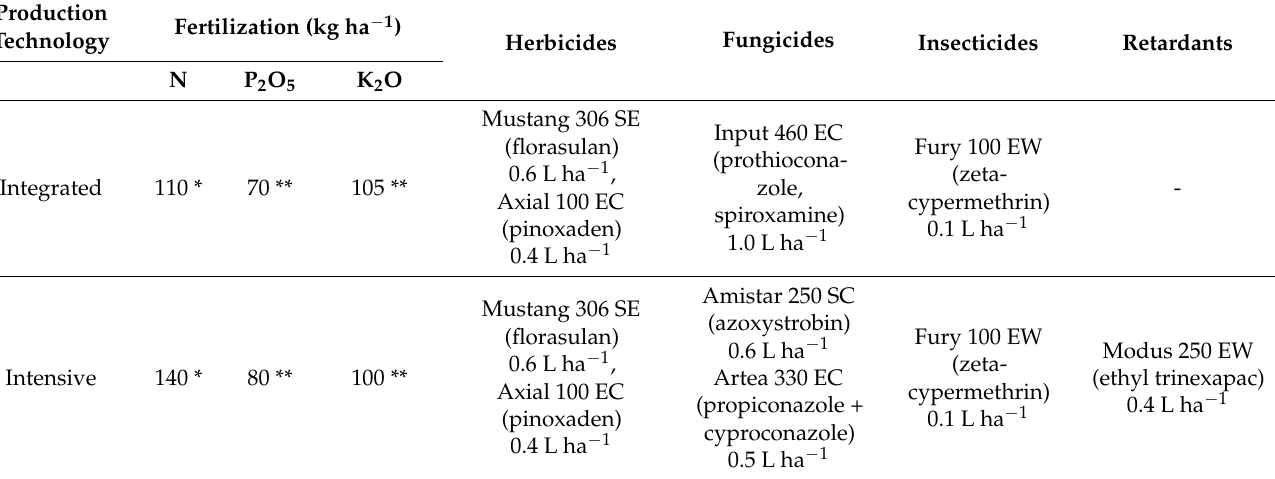
Table 5. Characterization of applied technologies for wheat